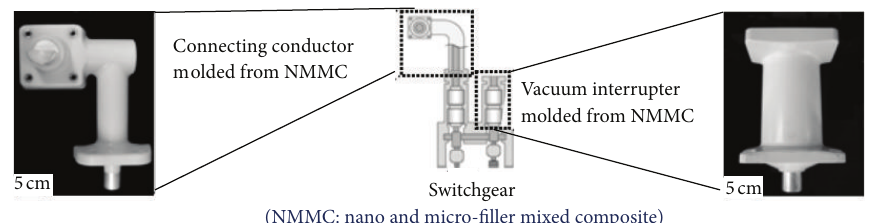
Figure 7: Development of switchgear components using nanocomposites